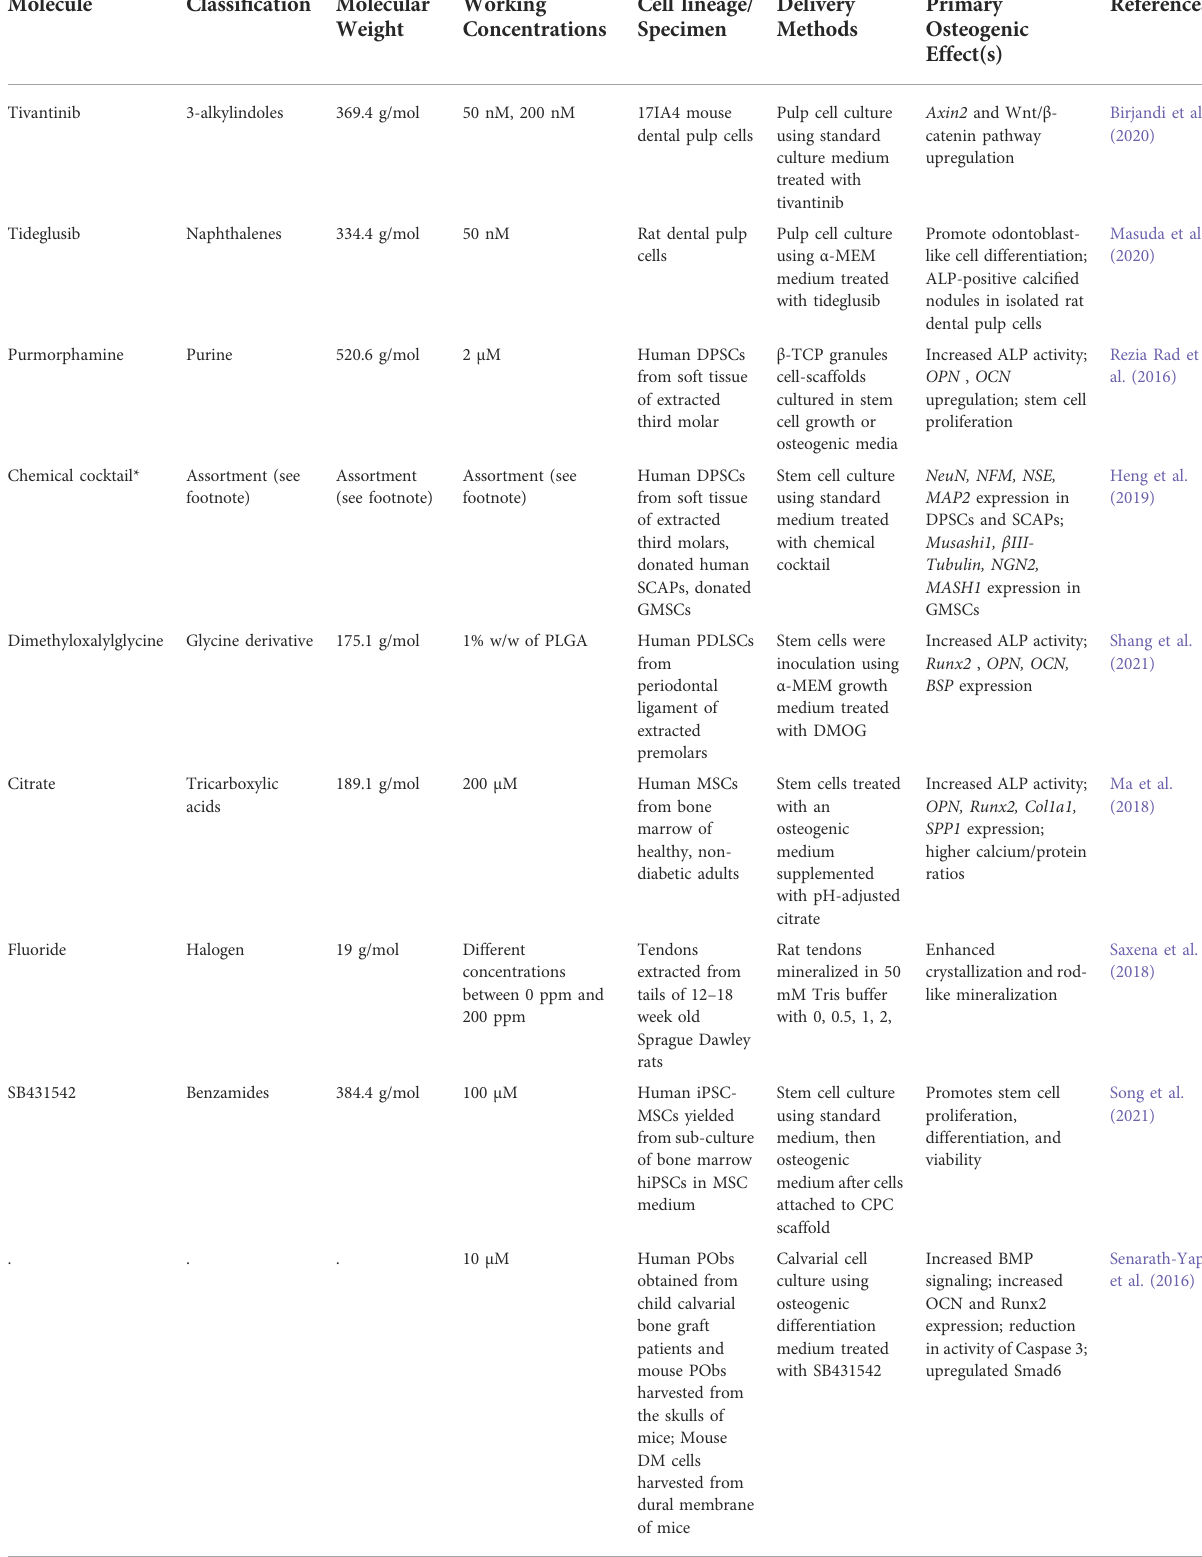
TABLE 1 Small molecular agents examined in vitro